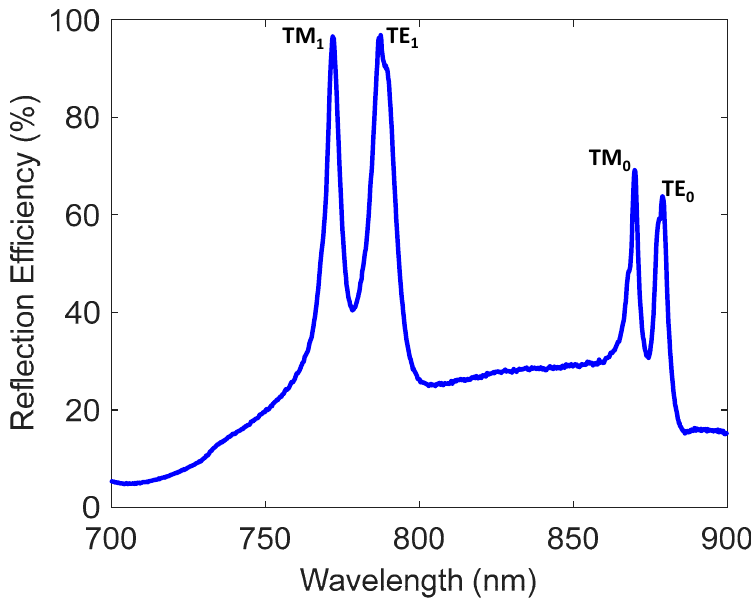
Figure 6. Measured unpolarized reflection spectrum of our bare GMR biosensor, with deionized (DI) water background, whose AFM is shown in Figure 2c. From lowest to highest wavelength, the peaks are due to TM 1 , TE 1 , TM 0 , and TE 0 resonant modes as labeled on the figure.